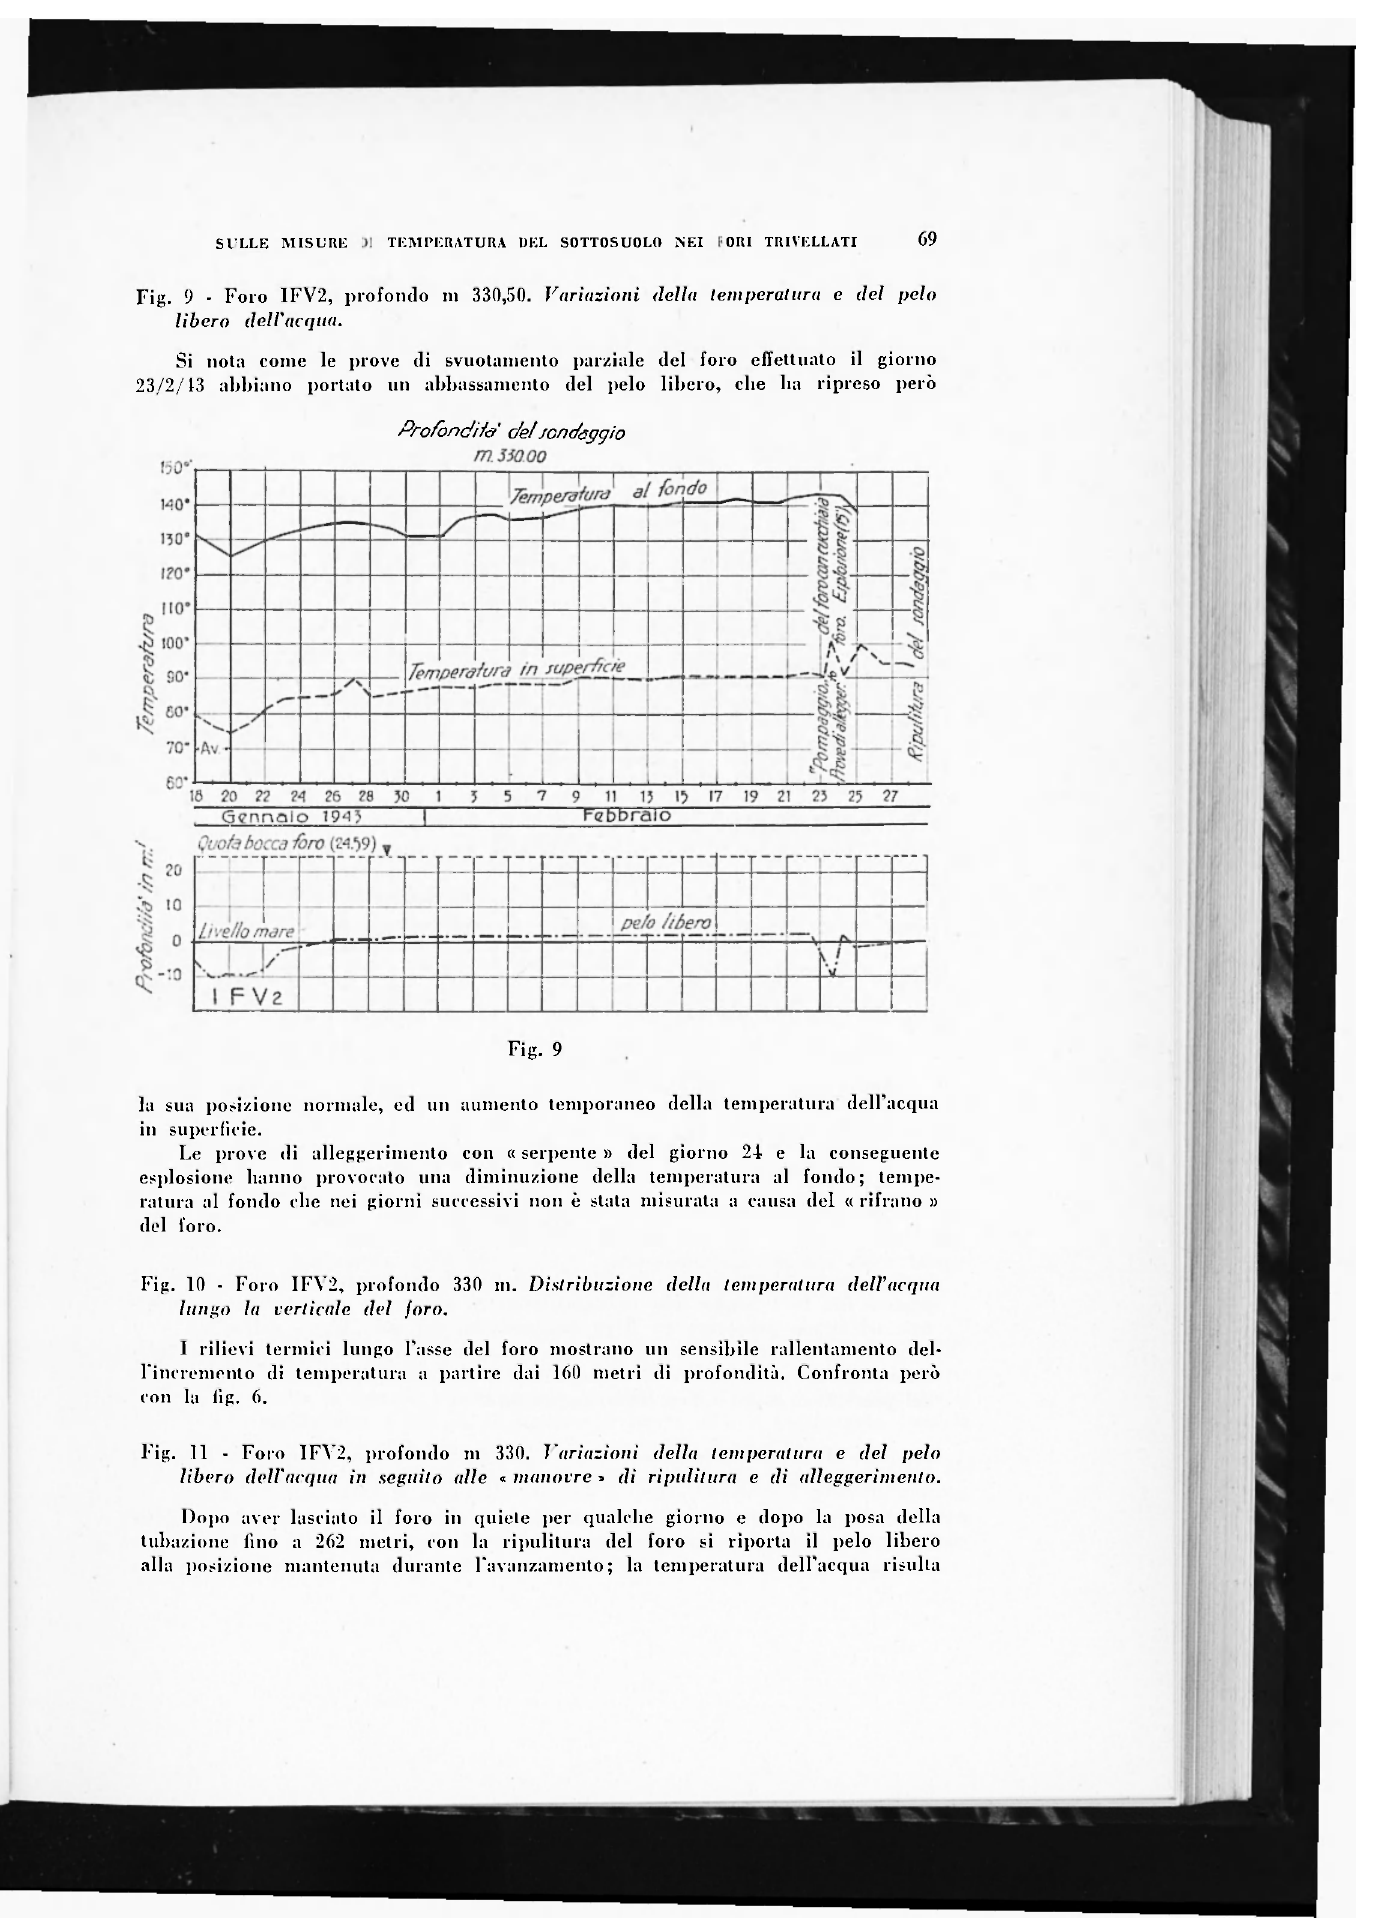
Fig. 11 - Foro IFV2, profondo m 330. Variazioni della temperatura e del pelo libero e di